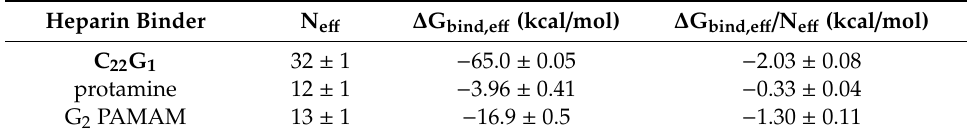
Table 2. E ff ective free energy of binding ( ∆ G bind,e ff ), number of e ff ective protamine / dendrimer